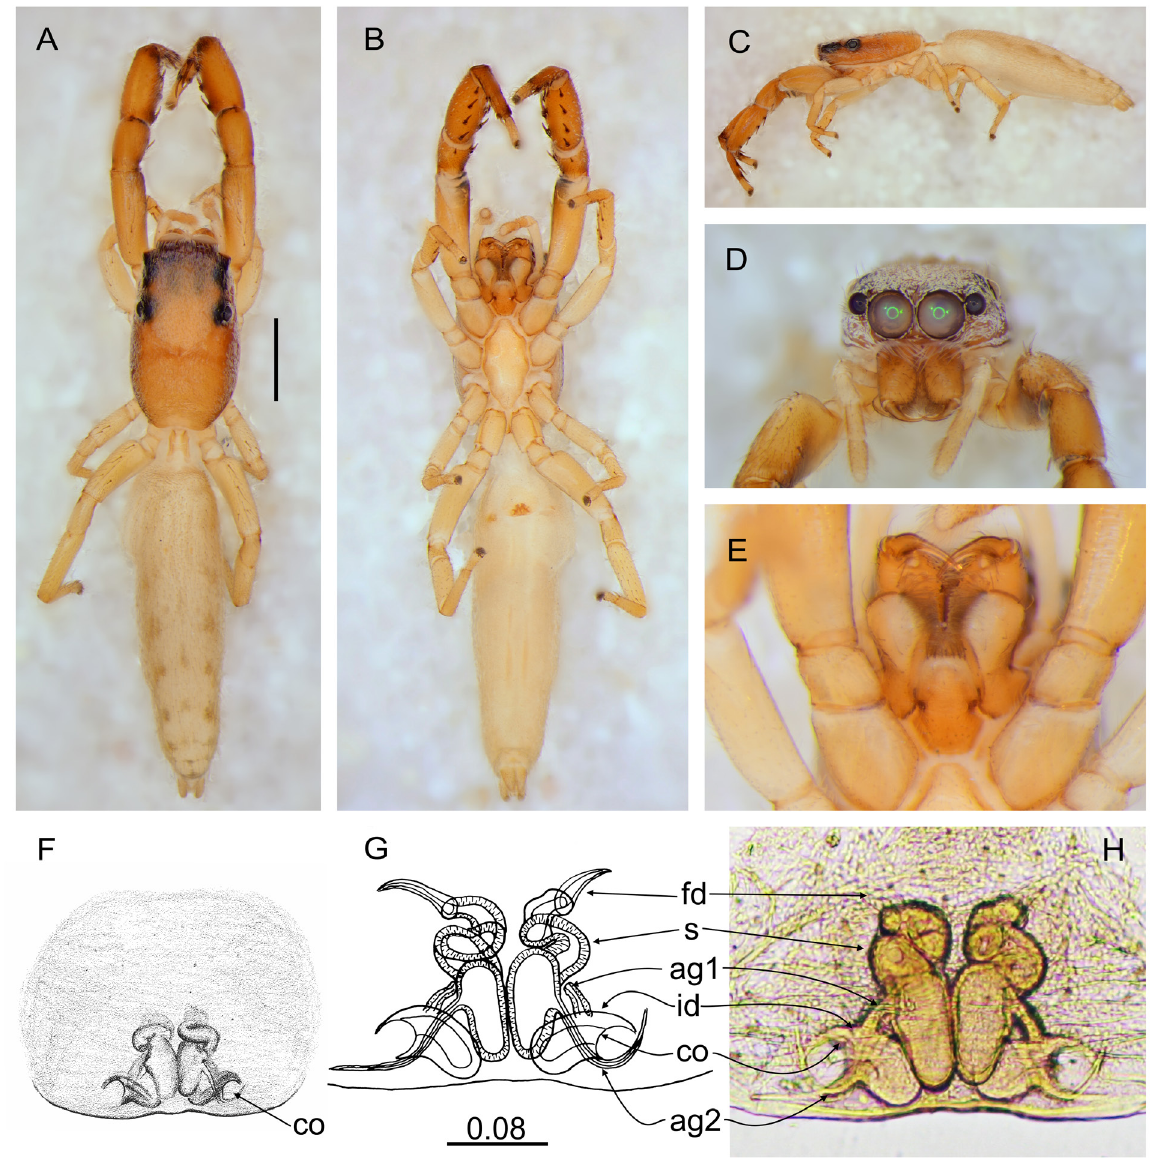
Fig. 5. Corambis jacknicholsoni sp. nov., paratype, ♀ (MNHN). A–D . Dorsal, ventral, lateral and frontal views. E . Chelicerae, maxillae and labium. F . Epigyne. G–H . Internal genitalia. Scale bar: A = 1